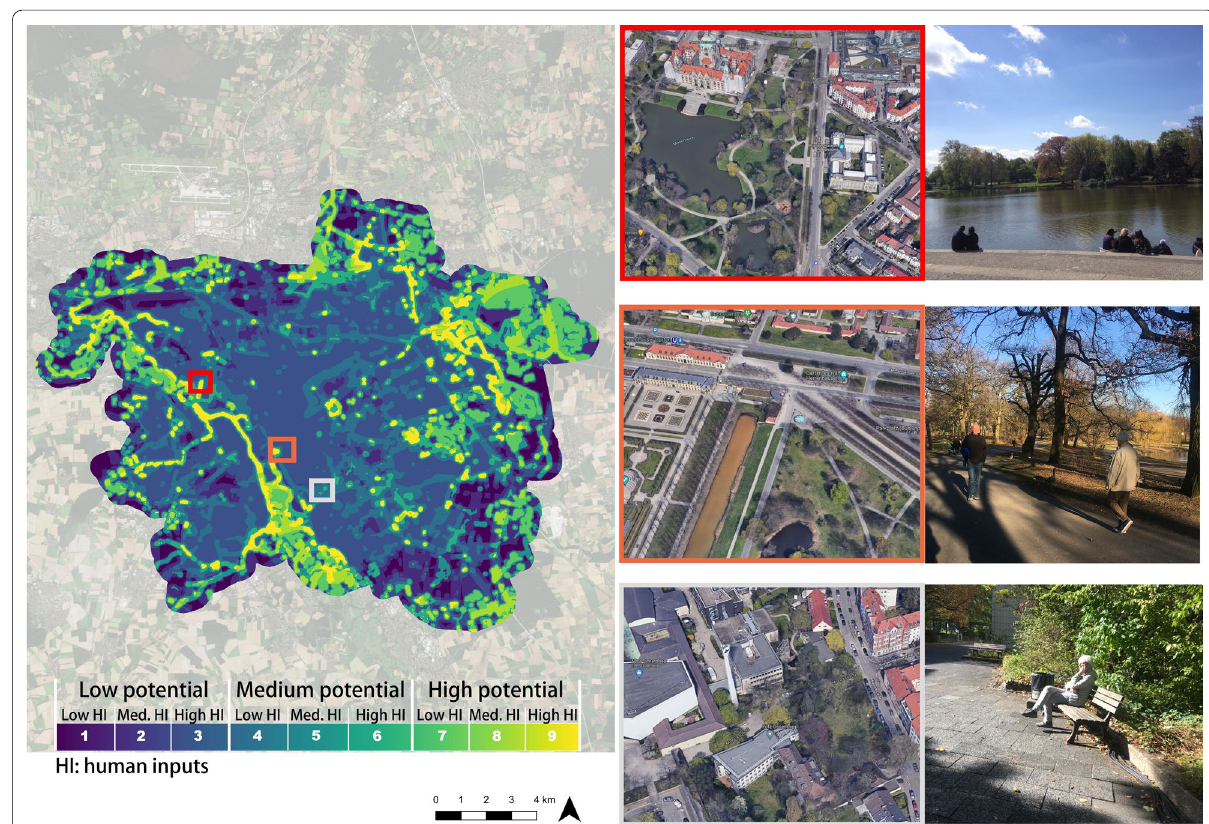
Fig. 7 NBR opportunities for elderly people. The left subgraph shows that the value of NBR opportunities is ranked to nine classes based on a cross-tabulation of NBR potential and human inputs. The map shows the range from the lowest opportunities (dark) to the highest (light). The right subgraph shows three sample sites, each of them demonstrating a 3D image from Google Map and a photo taken by the authors. The three sample sites represent typical places with high opportunities in the